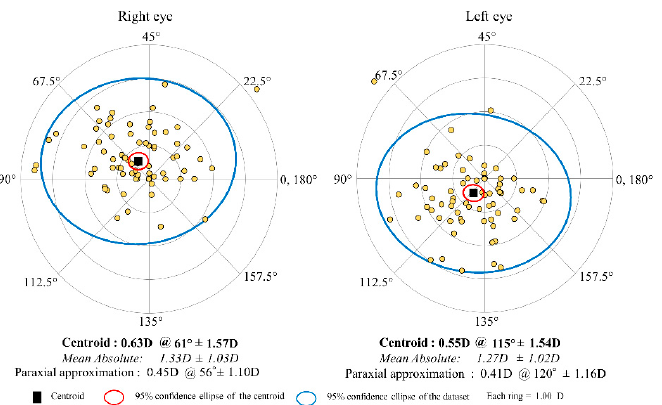
Figure 5. Graph showing the subjective refractive SIA of trabeculectomy with double angle plots in the right and left groups.